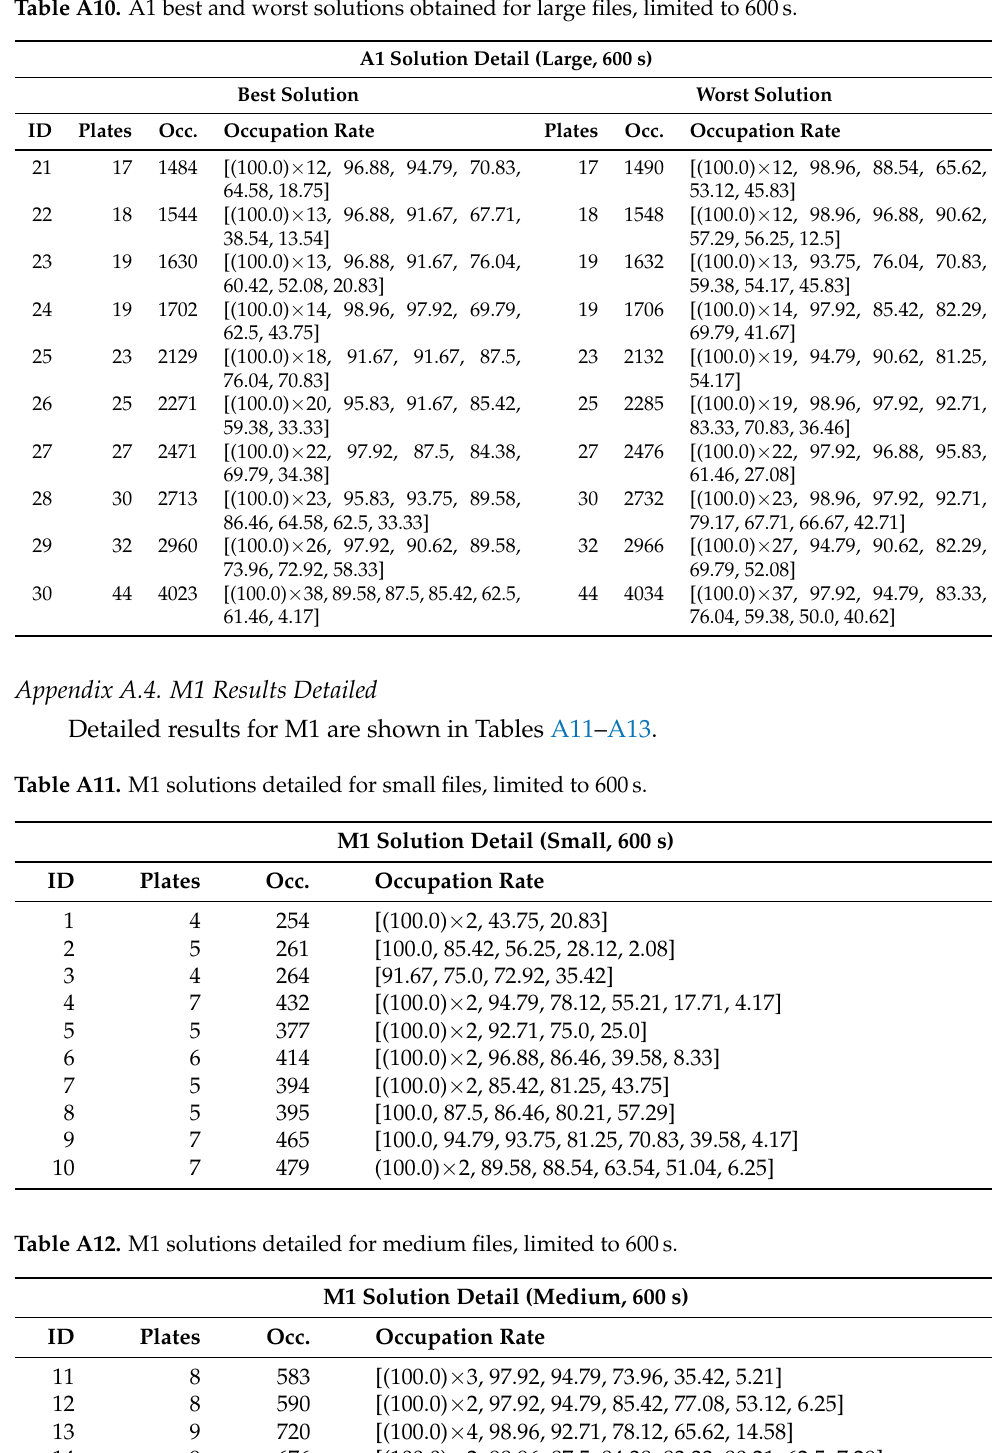
Table A10. A1 best and worst solutions obtained for large files, limited to 600s.